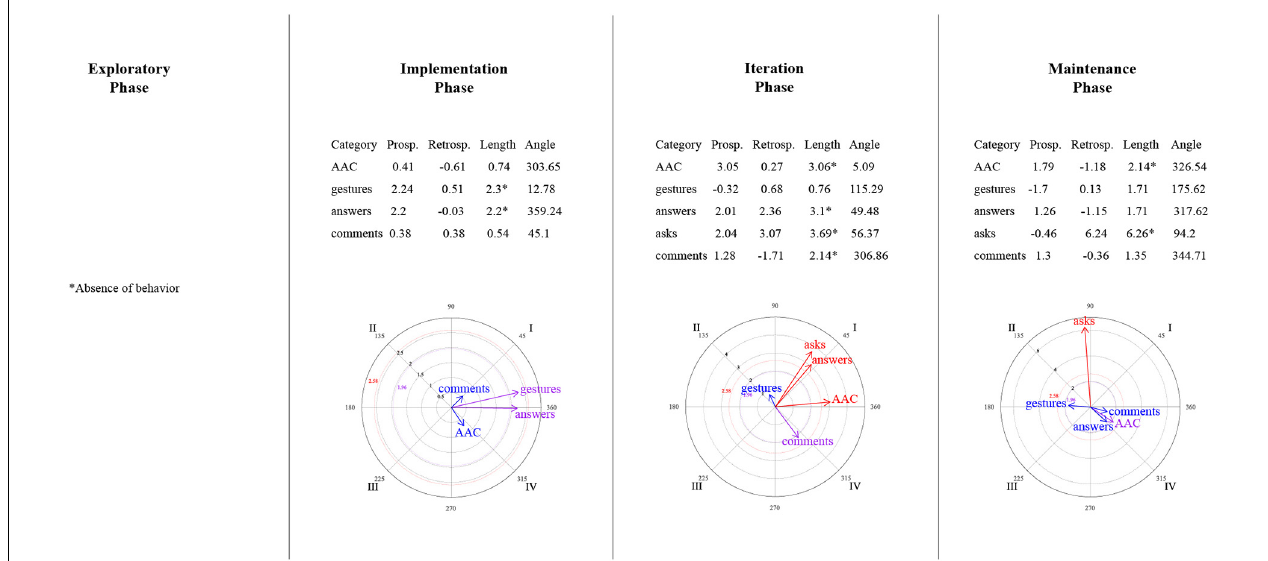
FIGURE 14 | Vectors corresponding to the mother’s AAC modeling as focal behavior, and the child’s emotion-related communicative turns [answers, comments, asks] and methods of expression [AAC, conventional gestures] as conditional behaviors.